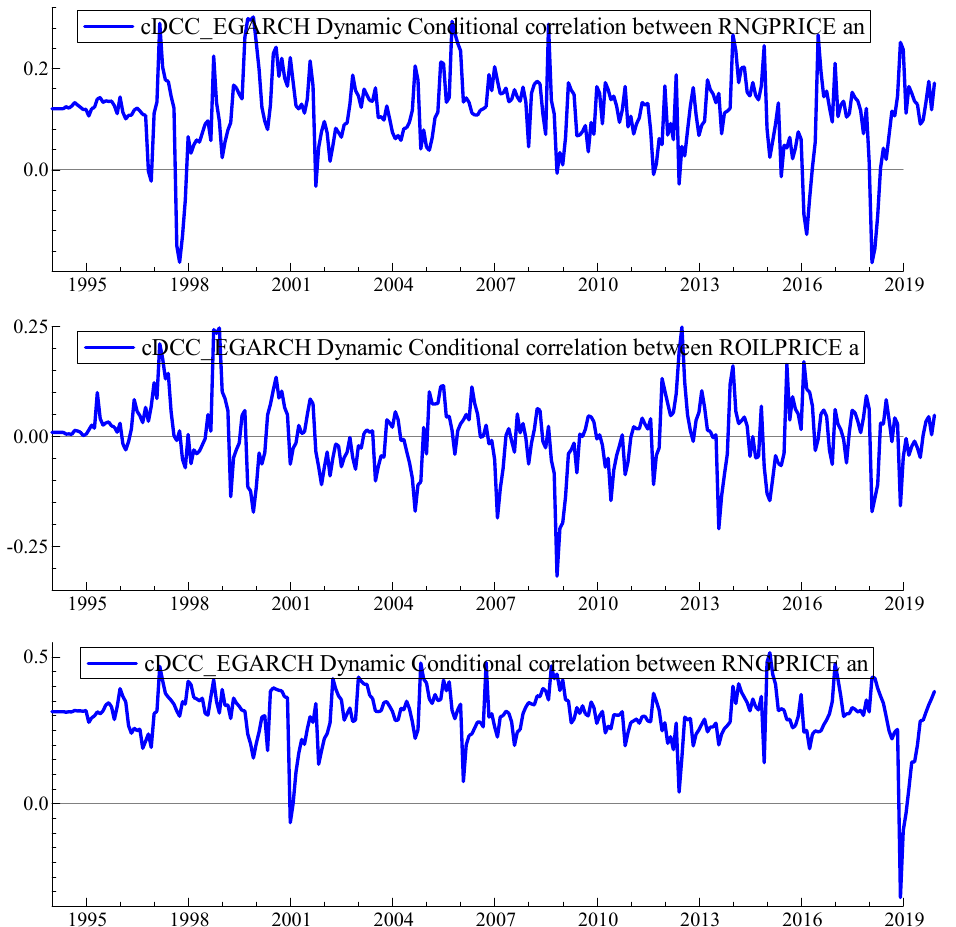
Figure 2. cDCC-EGARCH dynamic conditional correlations between Russian economic policy Figure 2 . cDCC-EGARCH dynamic conditional correlations between Russian economic policy uncertainty and energy uncertainty and energy prices.